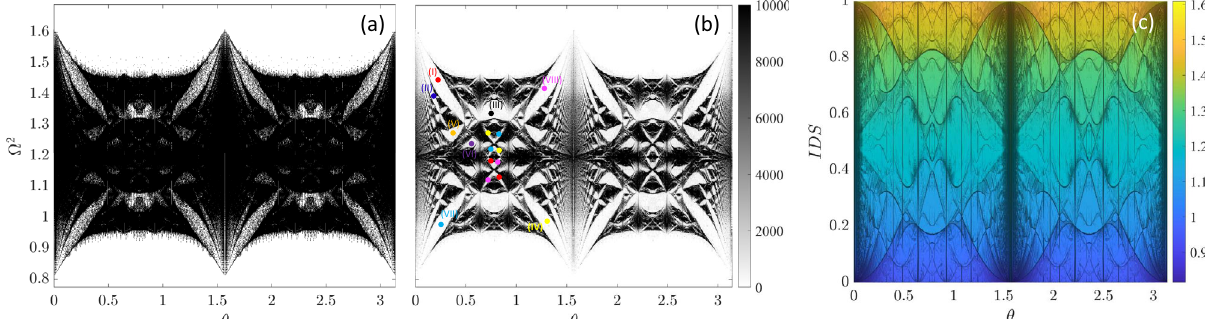
Fig. 2 Spectral properties of square lattice with β = π /2, a 1 = a 2 = 1. a Eigenfrequencies ( Ω 2 ) of 100 × 100 lattice calculated with periodic boundary conditions as a function of θ . The same result is repeated in ( b ), but color-coded by the associated density of states (colorbar). Particular gaps are marked by colored dots and labeled (I – VIII) for reference. c Integrated density of states (IDS) as a function of θ , where the color gradient represents Ω 2